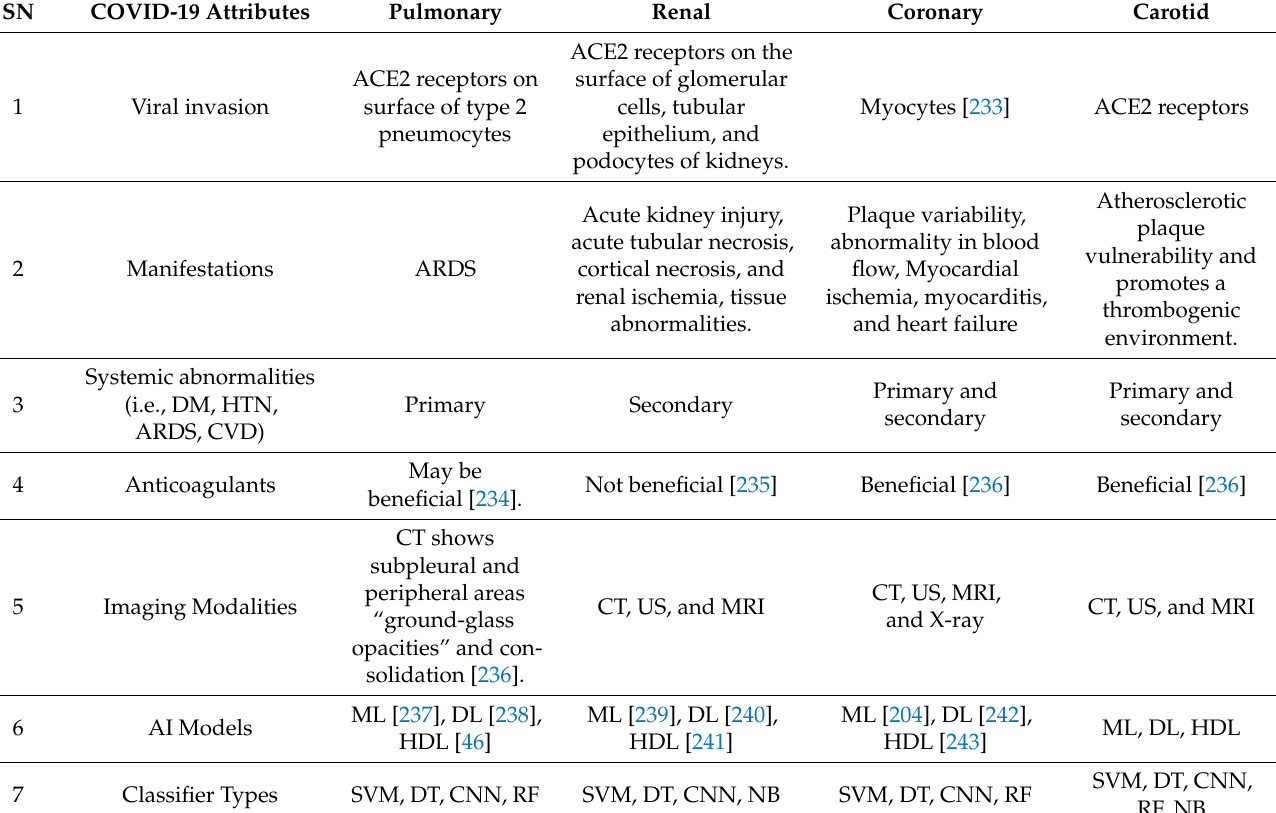
Table 5. Comparison of pulmonary, renal, carotid, and coronary artery damage due to